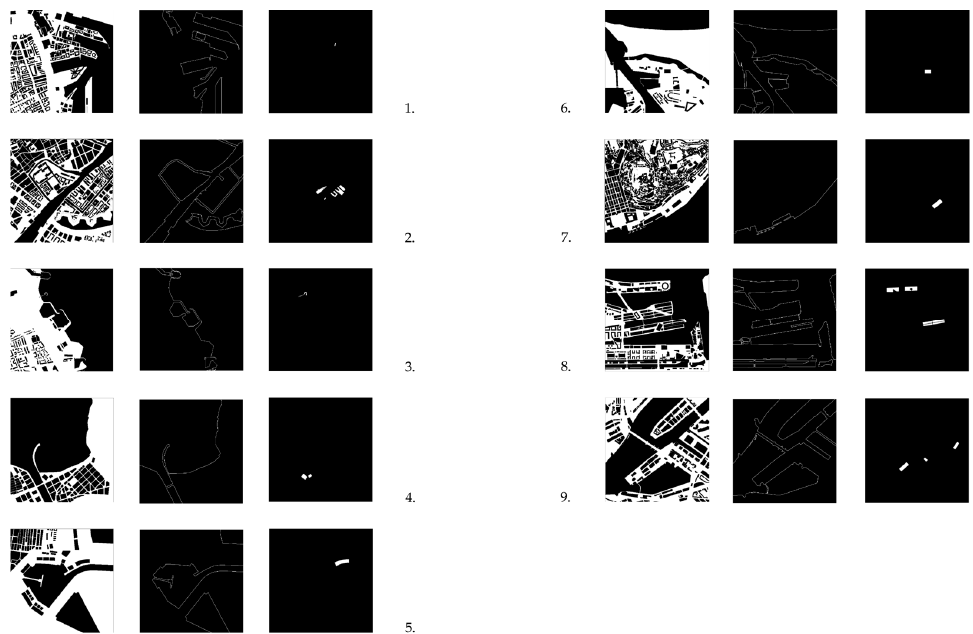
Figure 1. Waterfront public space decode. Authors’s Edition. Data: Google maps.